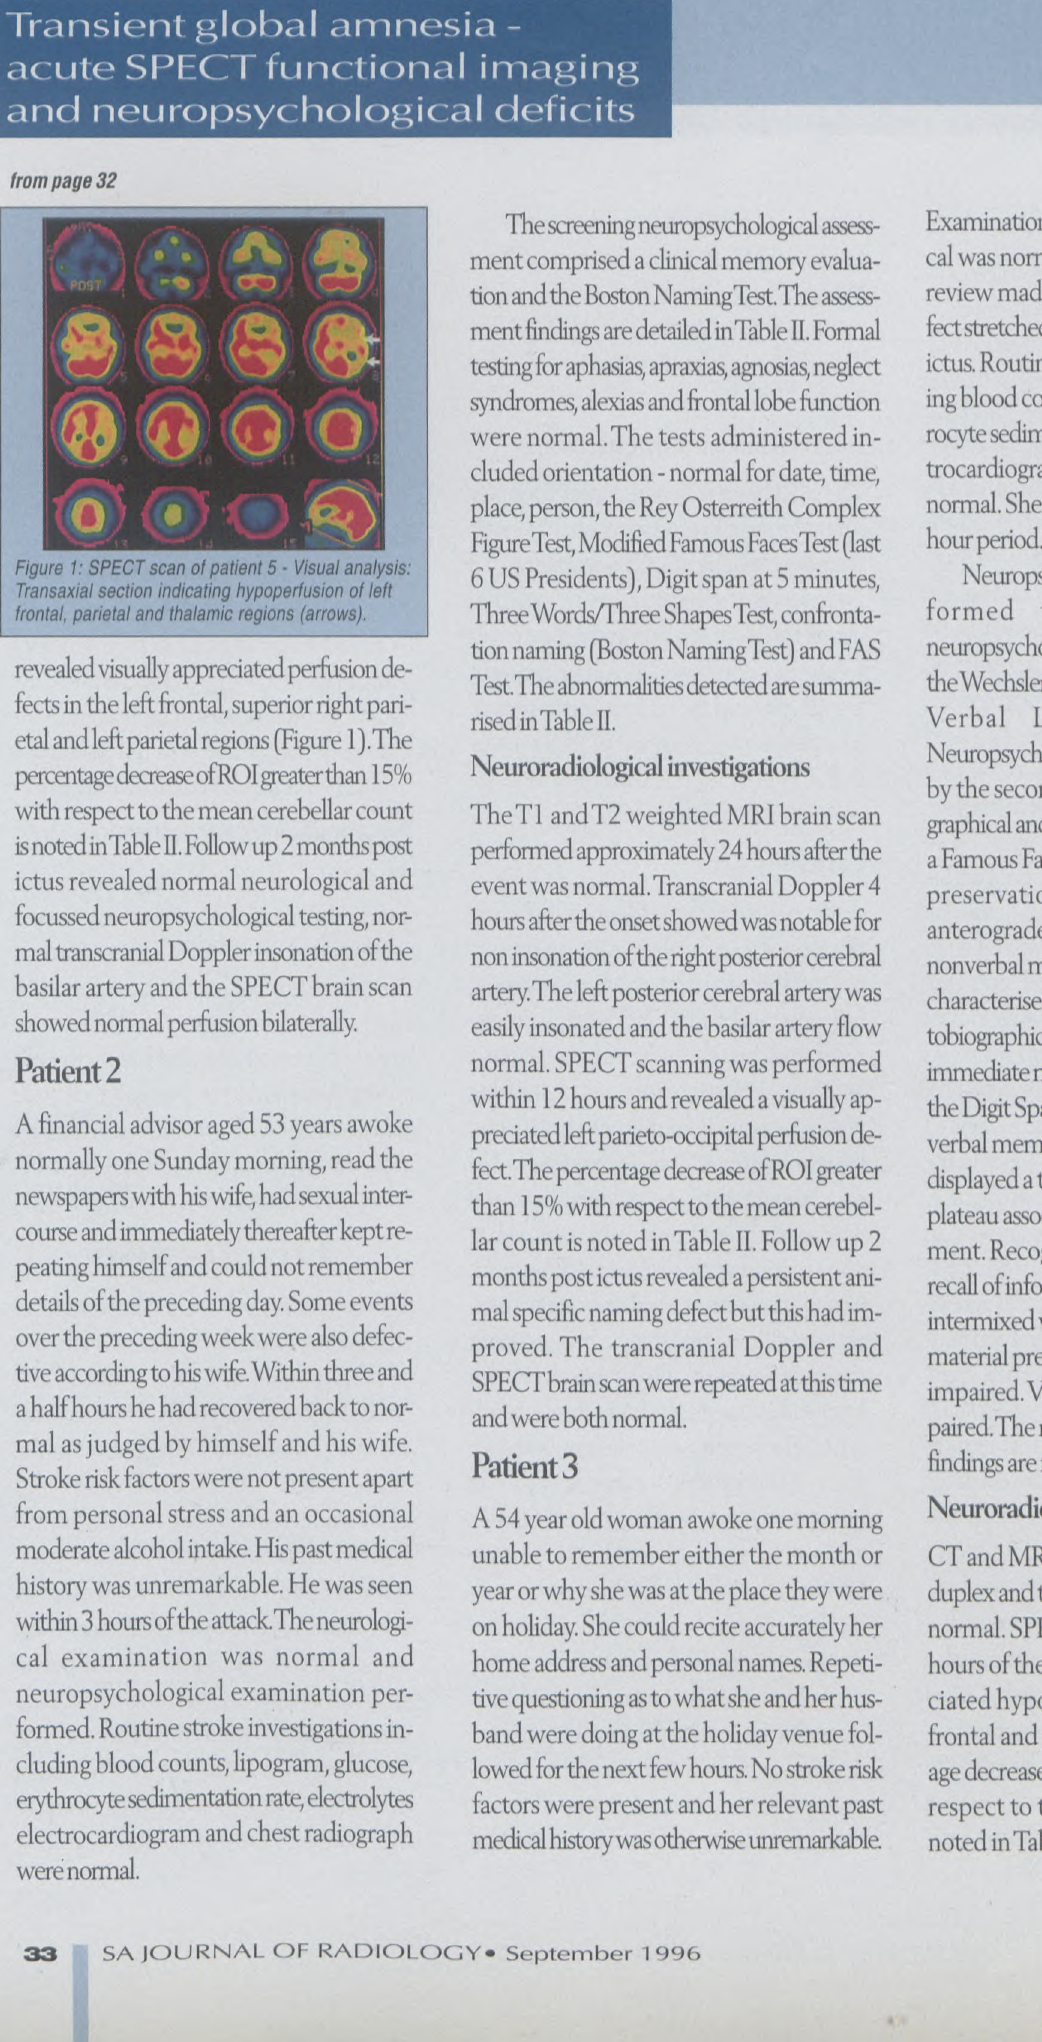
Figure 1: SPECT scan of patient 5 . Visual analysis: Transaxial section indicating hypoperfusion of left frontal, parietal and thalamic regions